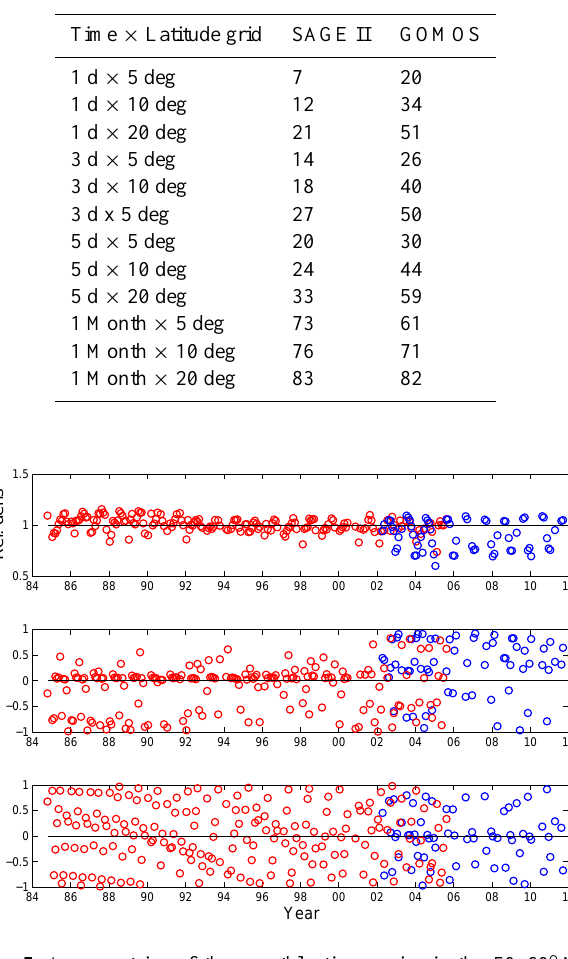
Fig. 5. Asymmetries of the monthly time series in the 50–60 ◦ N latitude range. Top: GOMOS and SAGE II ozone densities at 40km scaled by the median of the combined time series at 40km, middle: latitude asymmetries, bottom: time asymmetries. Red circles are for SAGE II and blue circles for GOMOS data.